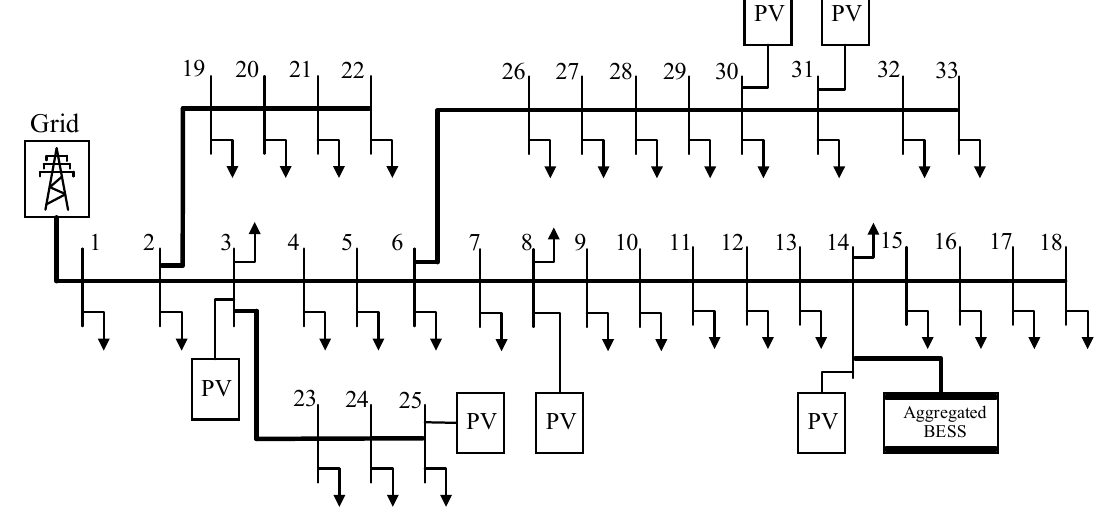
Figure 9. IEEE 33-Bus with PV and Aggregated BESS.